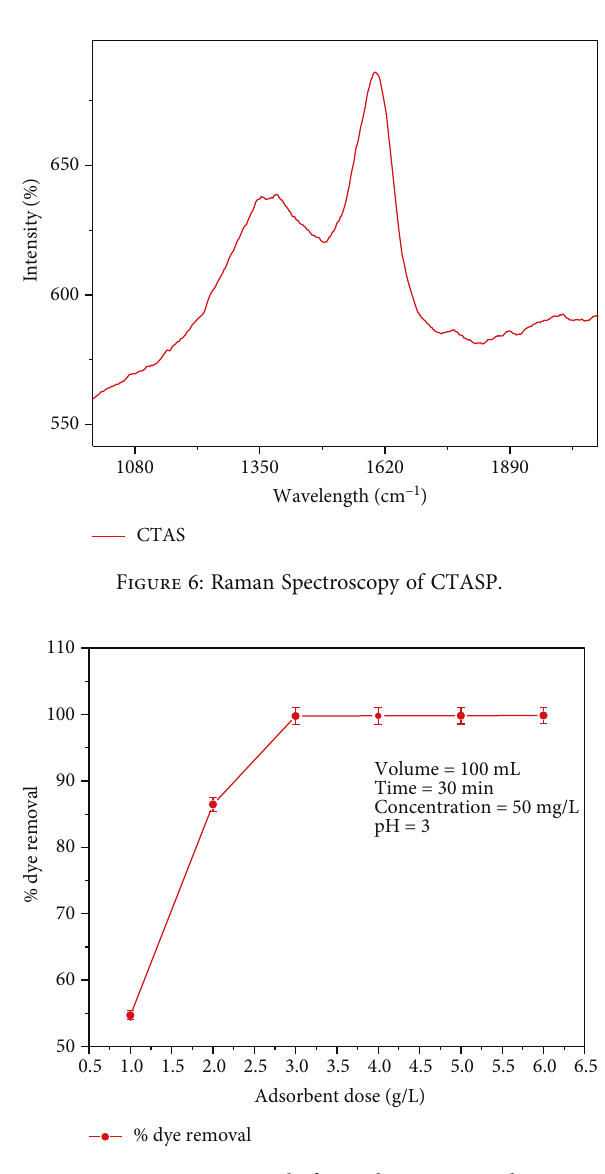
Figure 7: Percentage removal of ARS dye at various dose rates.